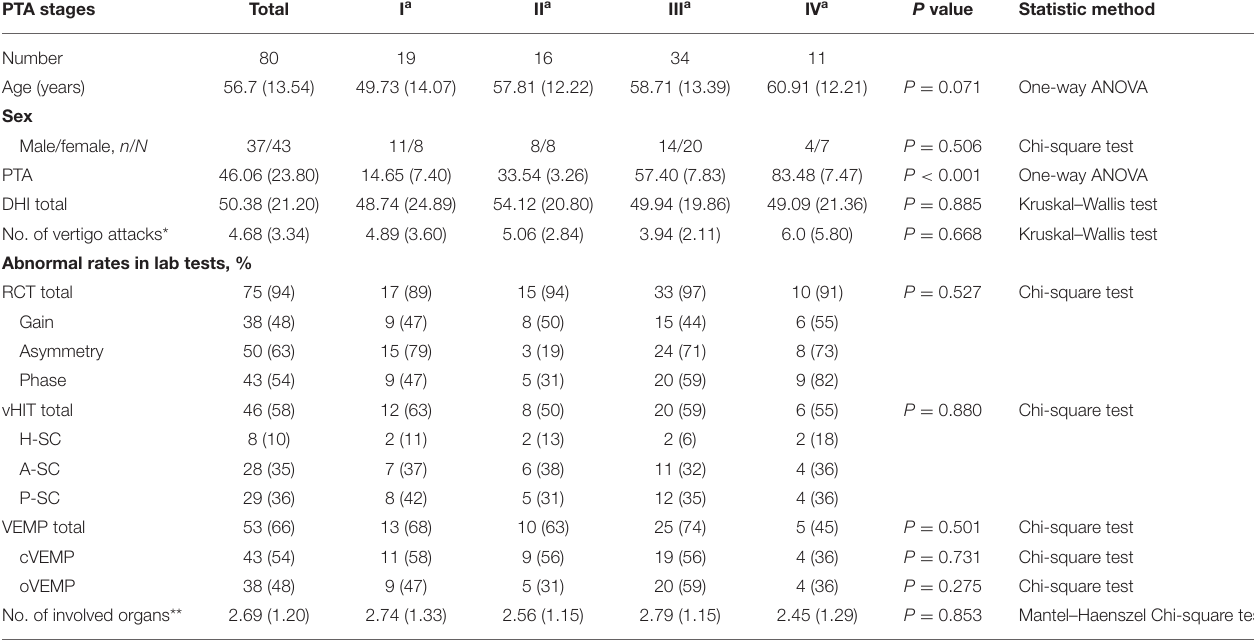
TABLE 1 | Comparison of clinical and test results across different PTA